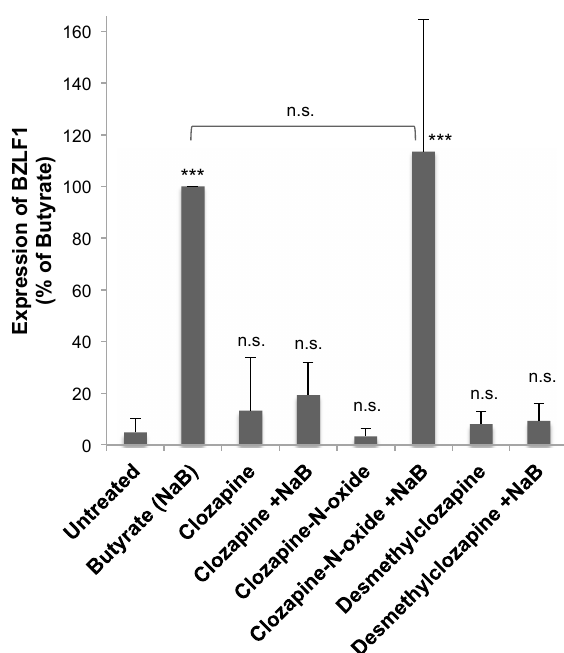
Figure 7. Desmethylclozapine, a metabolite of clozapine, inhibited EBV lytic reactivation, but clozapine-N-oxide did not. HH514-16 cells were treated with clozapine (50 μ M), clozapine N-oxide (50 μ M), or desmethylclozapine (50 μ M) for 24 h in the presence and absence of butyrate (NaB; 3 mM). EBV lytic reactivation was measured by the expression of BZLF1. The averaged data are plotted as a percent of the BZLF1 expression induced by NaB. Data represent the average and standard deviation of five biological replicates. Changes from untreated are marked n.s for not significant, p -value < 0.001 is denoted with ***, and p -value < 0.05 with *. The NaB and NaB+clozapine-N-oxide were not significantly different.